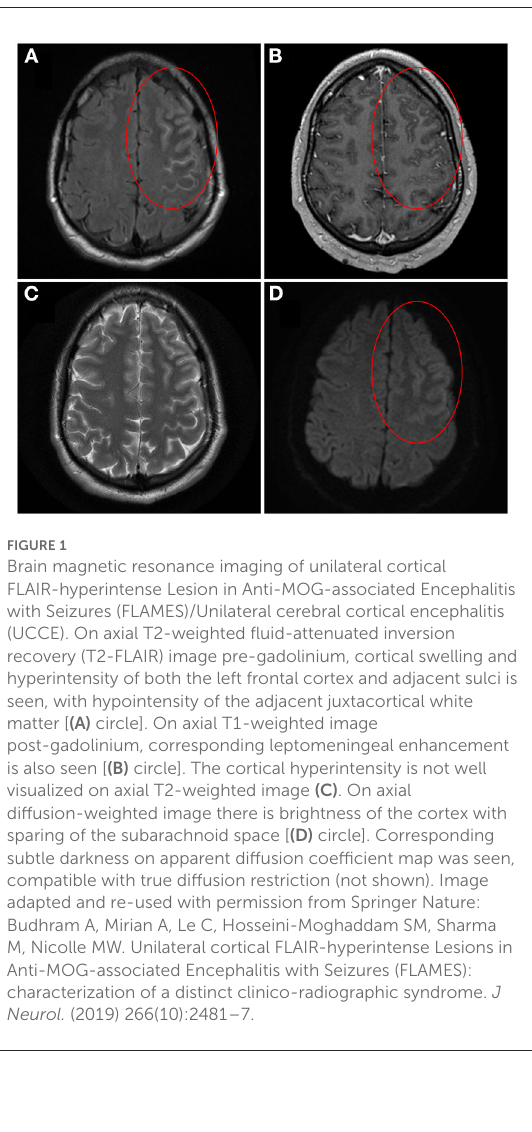
et al. described a 37-year-old female with a remote history of ADEM who presented with headache, fever and